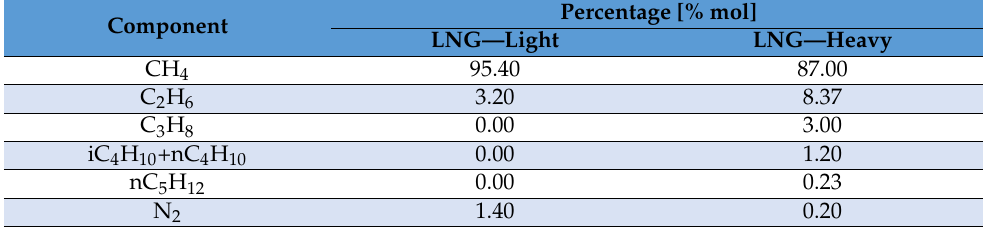
Table 1. The choice of an LNG type is dictated by qualitative and quantitative parameters of the LNG delivered to LNG terminal in ´Swinouj´scie (Poland). Table 1. Chemical composition of